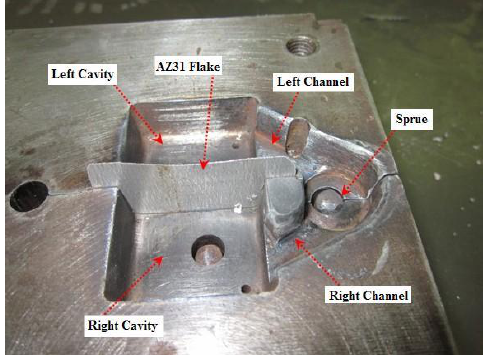
Figure 1. Mold device.